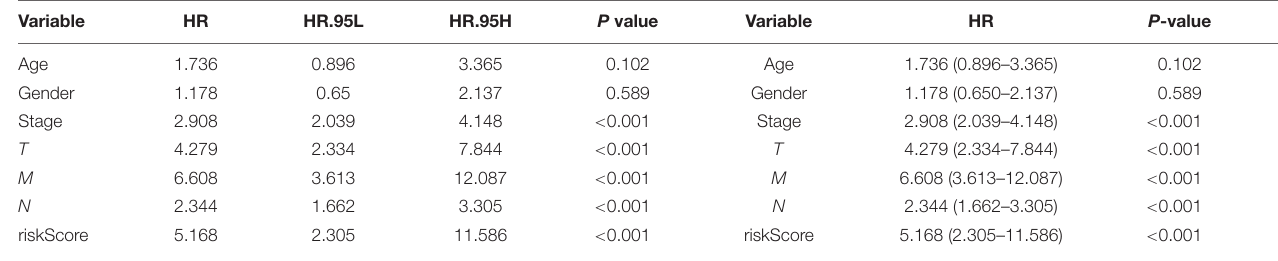
TABLE 4 | Univariate analyses of overall survival in CRC patients of